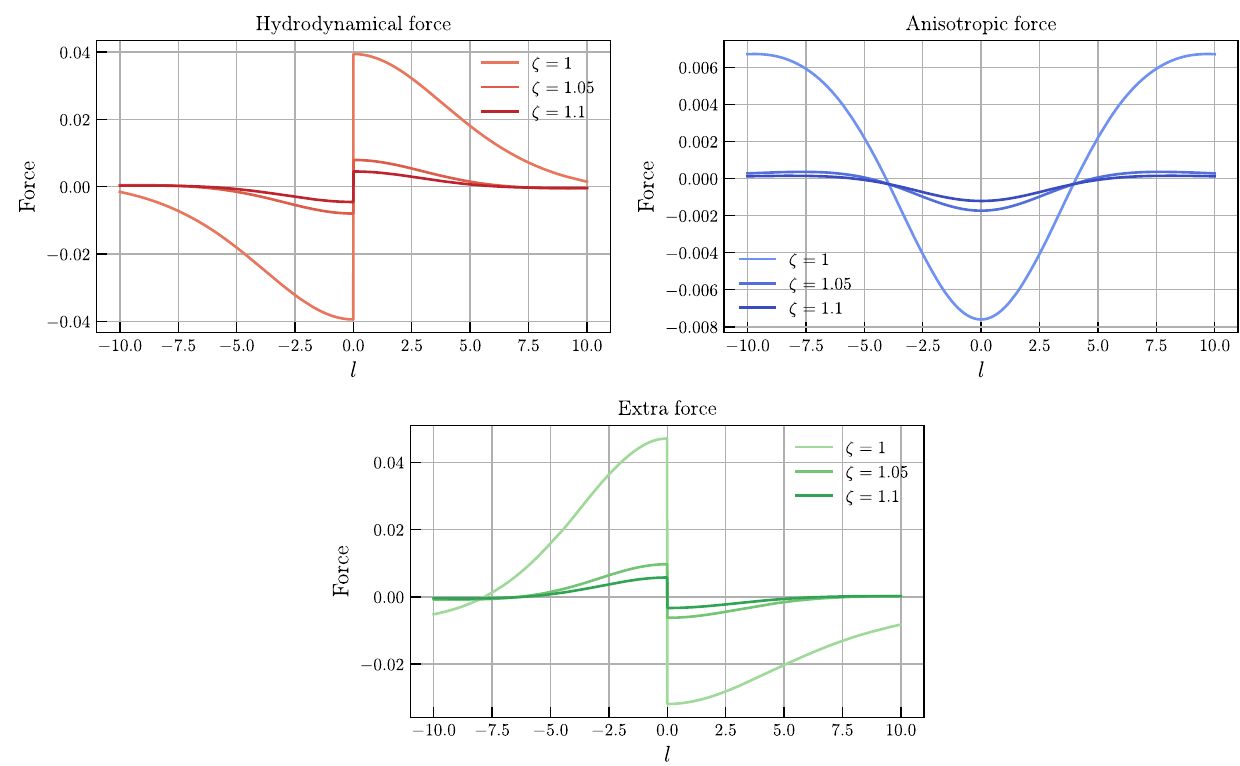
Fig. 4 Forces that are present in the modified TOV equation for the exponential f ( R ) gravity. As usual, we assume that b 0 = 5 and (cid:17) = 1, m = 2, α = 0 . 5 and β = 0 . 1 (cid:14)(cid:6) (cid:13) (cid:14) (cid:13) (cid:17) r (cid:7) − 4 ζ r (cid:7)(cid:7)(cid:7) + ζ 2 (cid:17) r 3 r (cid:7)(cid:7) + ζ 2 r 2 r (cid:7) r (cid:7) 2 − 1 1 − 3 r (cid:7) 2